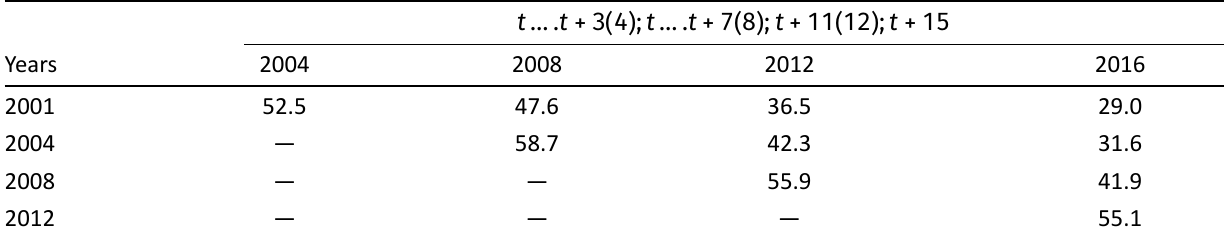
Table 2. The proportion of those staying in TGHs from one wave to another (panel